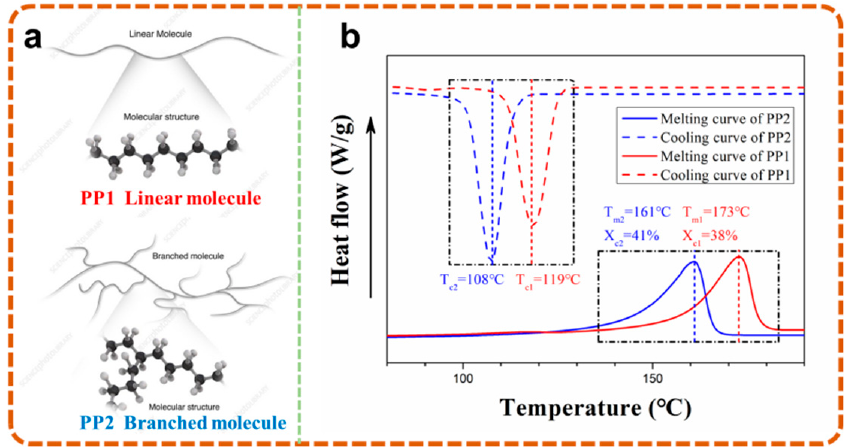
Figure 4. Molecular configuration ( a ) and thermal properties ( b ) of PP1 and PP2.